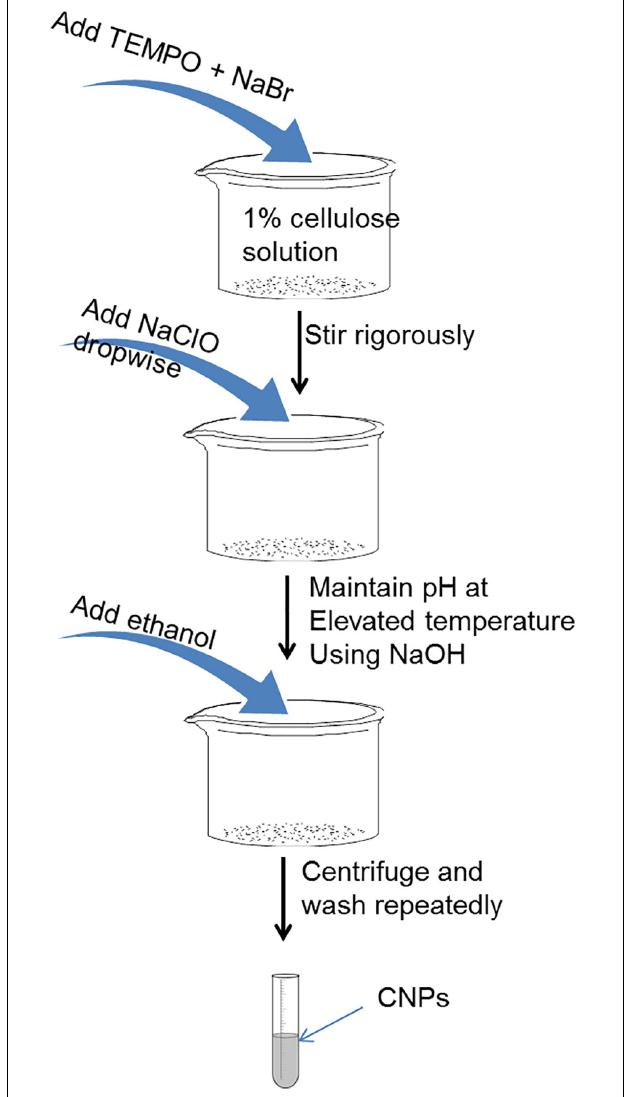
FIGURE 4 | Schematic for TEMPO mediated oxidation